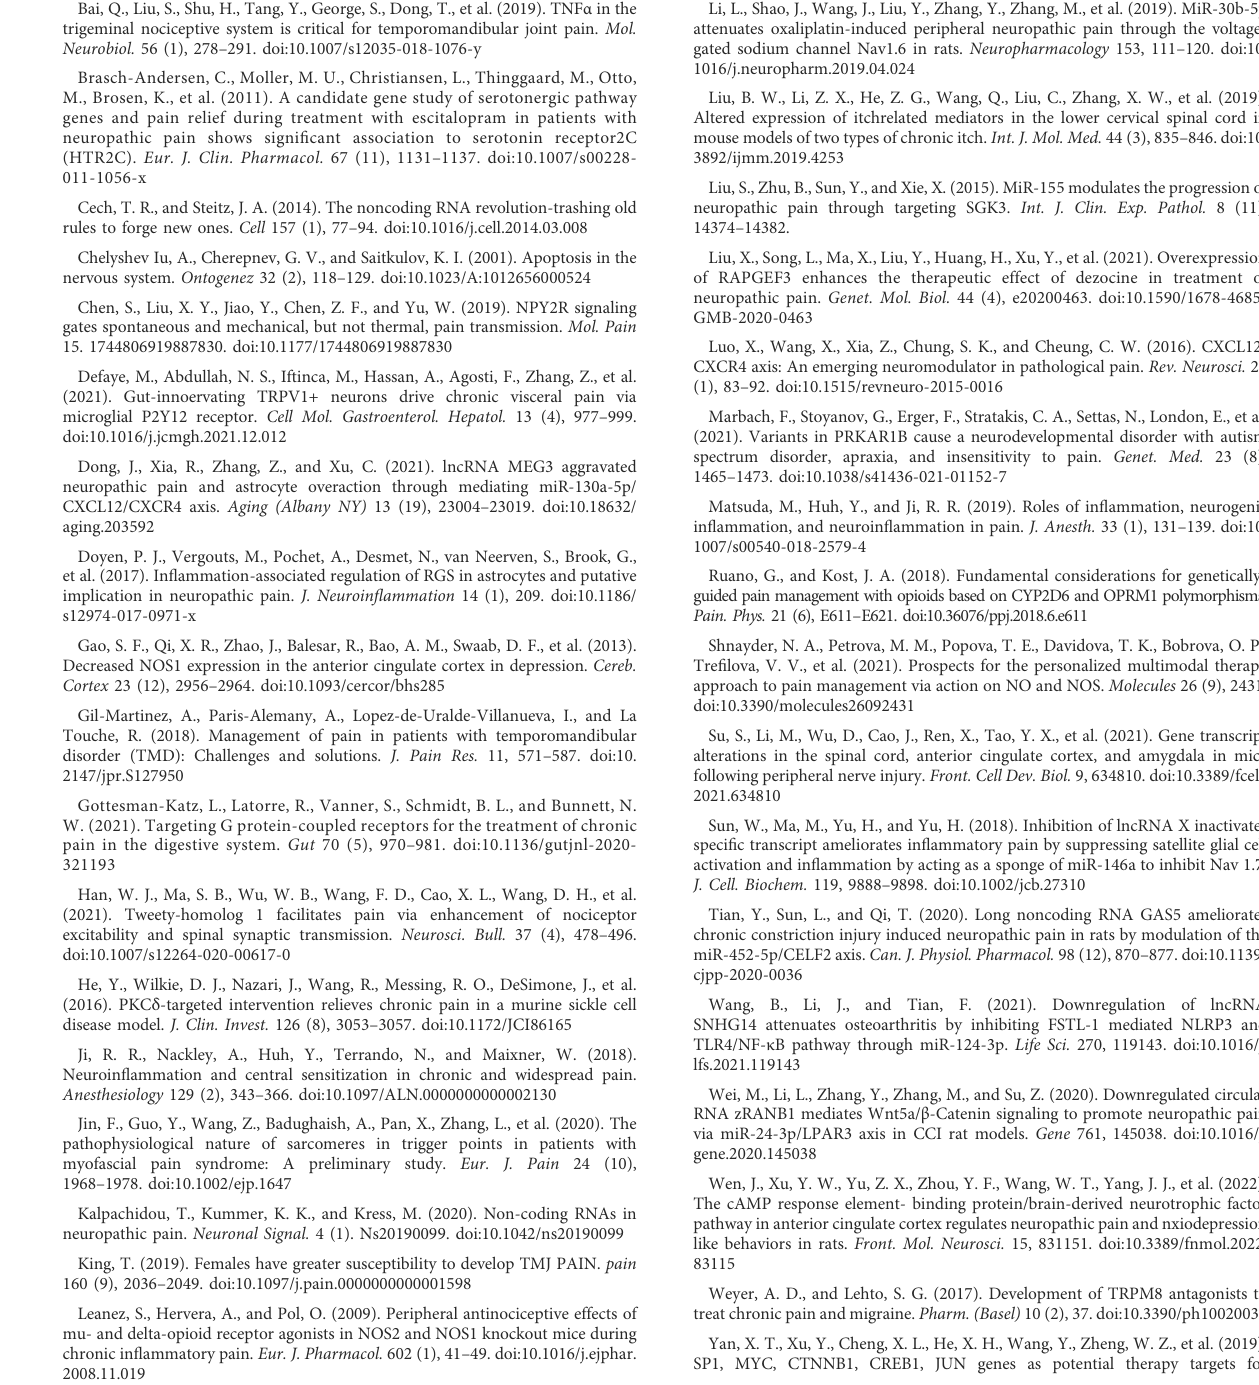
biological process (A) , molecular function (B) , and cellular component (C) . (D) signi fi cant molecular function, biological process, and cellular component enrichment analysis of DE mRNA. The enrichment scores ( − log10 (p value)) of the GO term were shown in the histogram. (E) the DE mRNA-enriched KEGG pathways represented by enrichment scores ( − log10 (p value)). (F – J) DE mRNAs on